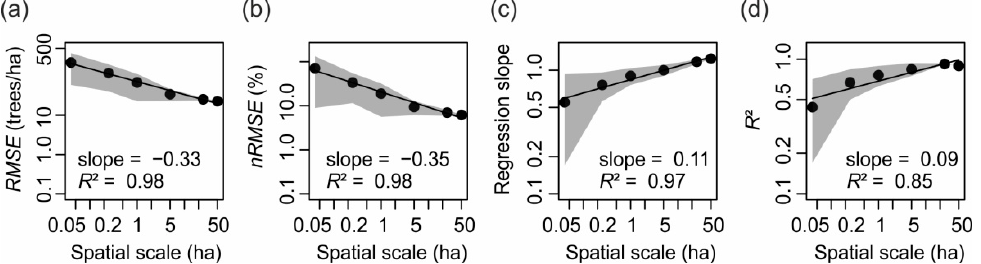
Figure 5. Scaling relations between plot size and goodness-of-fit measures. ( a ) The RMSE between lidar-derived and inventory-based stem numbers of subplots is shown (mean: black dots, standard deviation: grey polygon) with increasing plot size (ha). Please note the log–log axes. A linear regression (black line, based on black dots) provides a slope and R ² of the respective scaling relation. A similar analysis is given for ( b ) nRMSE (%), ( c ) the regression slope of lidar-derived and inventory-based stem numbers, and ( d ) coefficient of determination R ². Please note the different sample sizes for the different spatial scales (see also Table 3 and Table A2 for details).